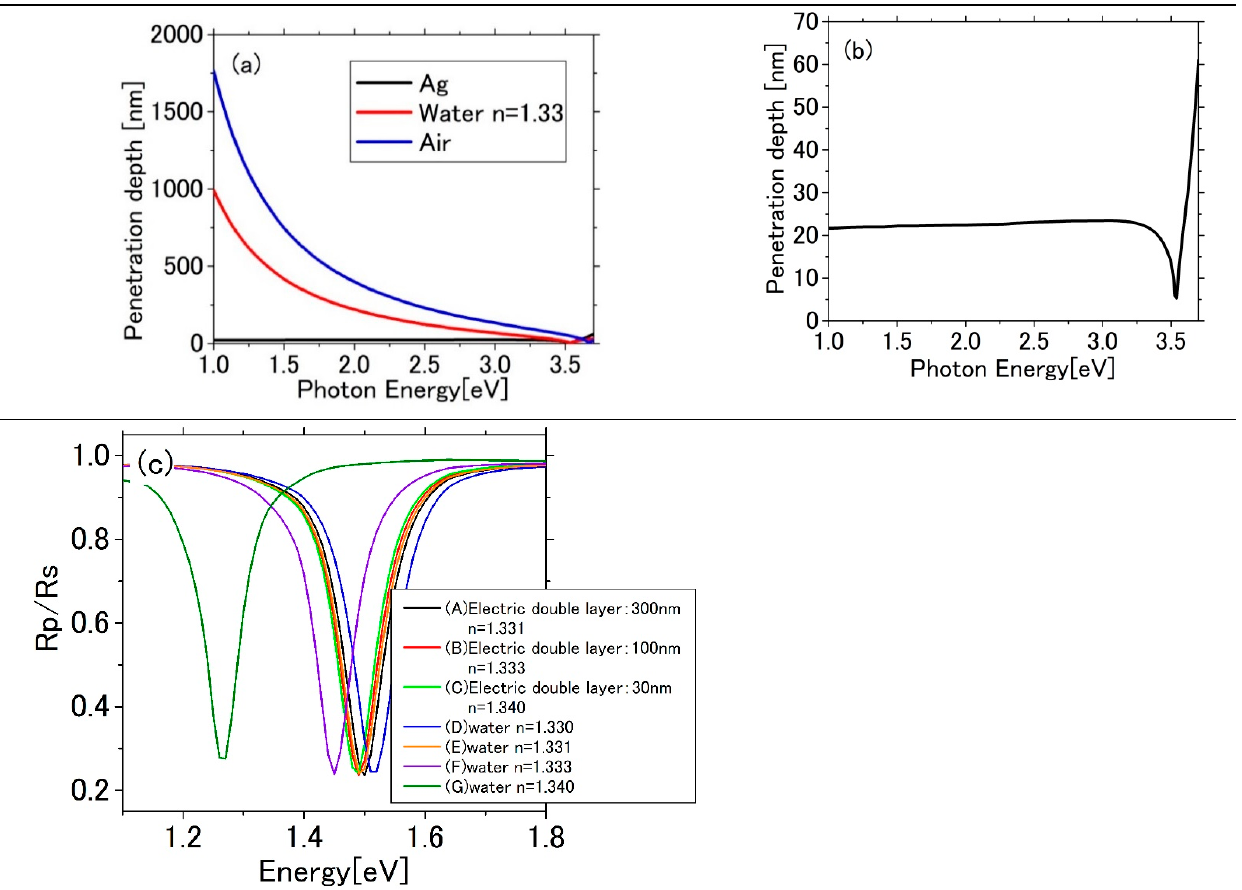
Figure 8. ( a ) Penetration depth of SPP as a function of photon energy. ( b ) Enlarged graph for the penetration depth into the metal side. ( c ) SPP resonance spectra calculated by the transfer matrix method under the same Kretschmann configuration as in the experiment with an incident angle of 70.3°. Table 2. The energy shift of the SPP resonance from that with n = 1.330 in Figure 8c.